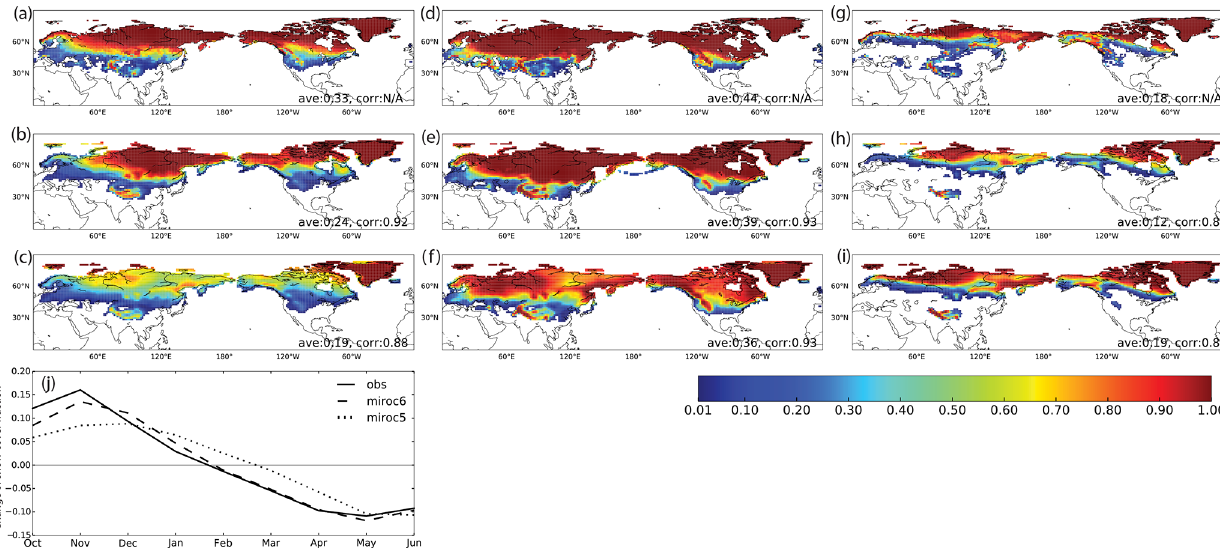
Figure 12. Snow cover fractions for observations (a, d, g) , MIROC6 (b, e, h) , and MIROC5 (c, f, j) . Maps in November, February, and May are aligned from the left to the right. The unit is nondimensional. Areas where snow cover fractions are less than 0.01 are masked. “Ave” and “corr” in the panels indicate spatial averages and correlation coefficients between observations and models over the land surface in the Northern Hemisphere, respectively. Time series in (j) shows the temporal rate of change of the monthly spatial averages. The snow cover dataset of the Northern Hemisphere EASE-Grid 2.0 is used as observations.